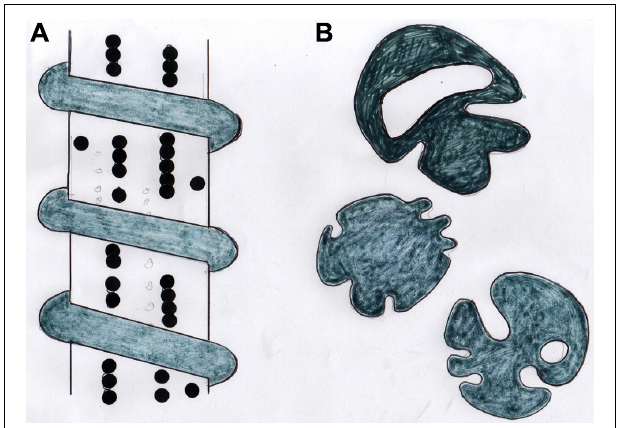
FIGURE 3 | Diagram showing (A) a stylized CIII/CVI-rich periosteal Sharpey’s fiber with adherent beaded chains of tenascin and encircled by a coil of elastin, and (B) tracings of the same coarse fibers (about 15 μ m diameter) in cross section showing their typical irregular profiles. After Aaron and Skerry